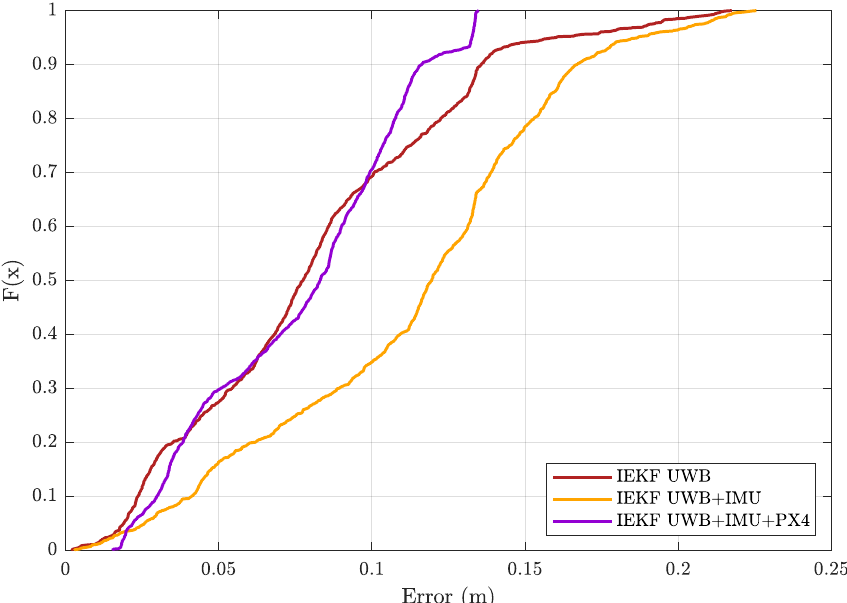
Figure 14. Empirical cumulative distribution function (ECDF) of position error in scenario